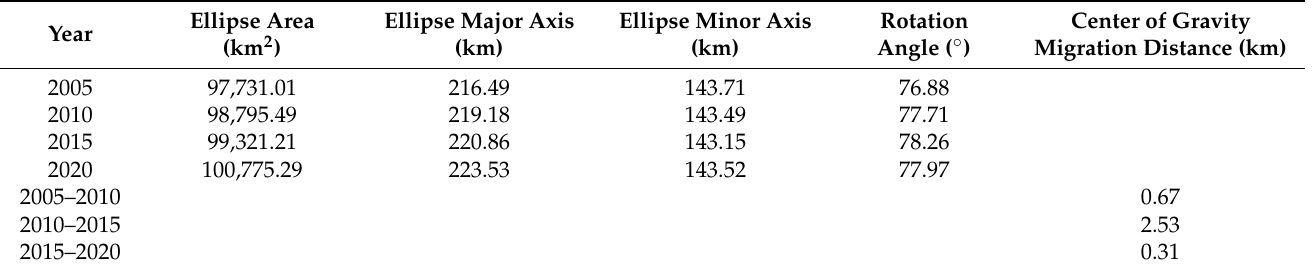
Table 10. Ellipse of the standard deviation of coupling coordination and center of gravity migration parameters for the CCCG,